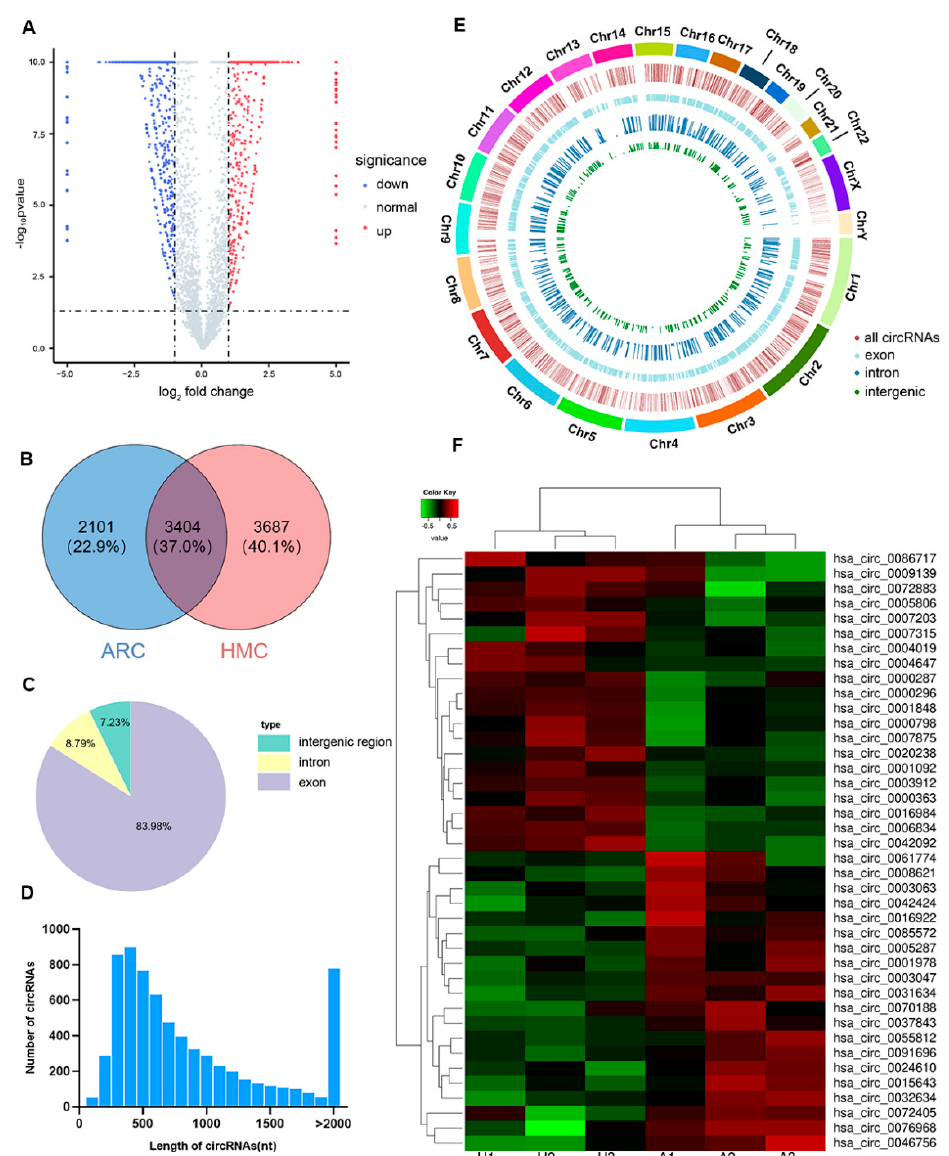
Figure 1. Total circRNAs detected by whole transcriptome sequencing in HMC and ARC lens epithelium samples. ( A ) Volcano plot of circRNAs. ( B ) The Venn diagram of overlapped circRNAs between HMC and ARC. ( C ) The genomic location of circRNAs. ( D ) The length distribution of circRNAs. ( E ) The chromosome distribution of circRNAs. ( F ) Hierarchical clustering analysis of the top 20 upregulated and downregulated DEcRs in HMC compared to ARC. Expression values are indicated by red and green shades, suggesting expressions above and below median expression level across all samples, respectively. H: HMC; A: ARC.